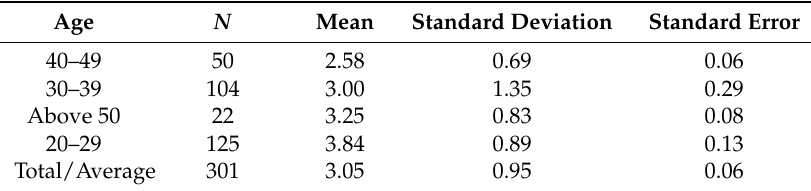
Table 2. Description of different ages.